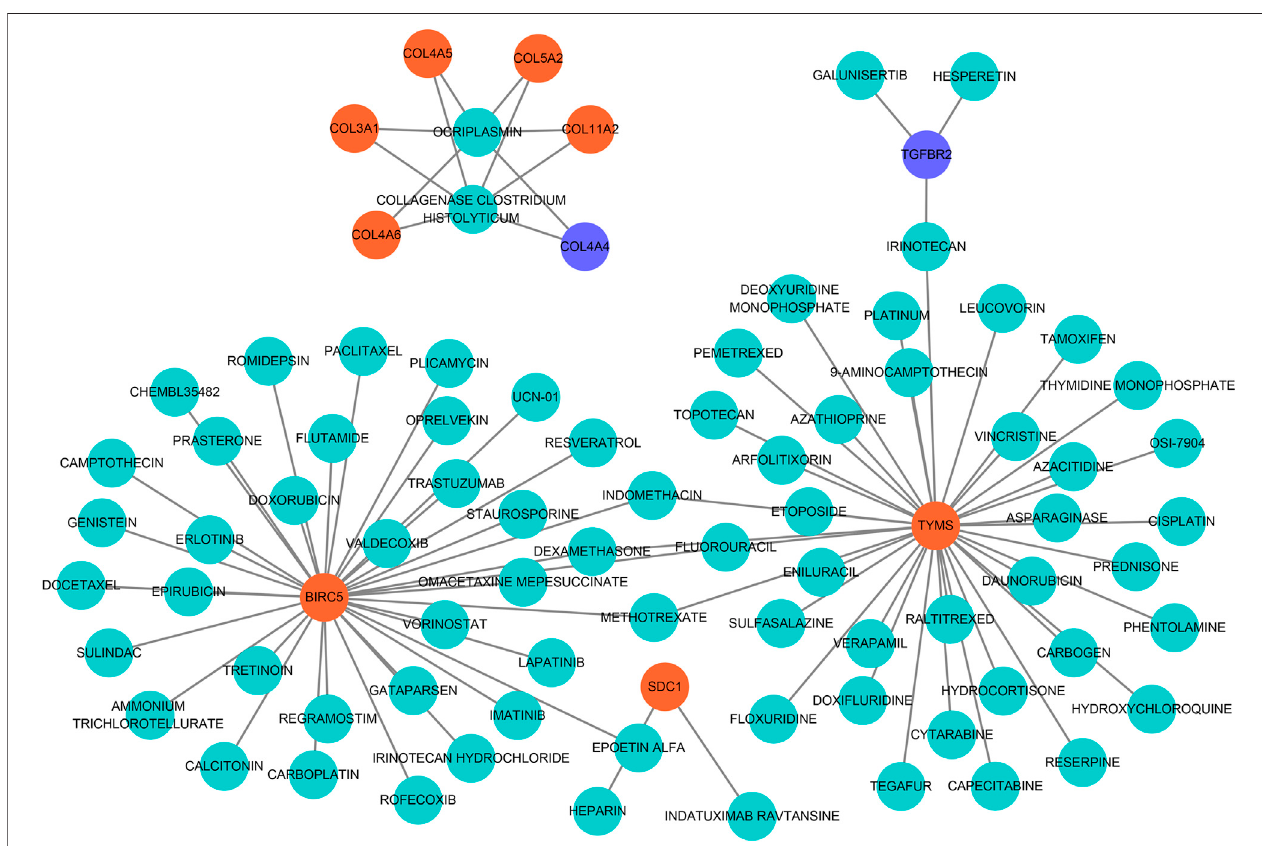
FIGURE 6 | Drug-hub DEGs regulatory networks. Cyan circles, potential target drugs; Orange circles, upregulated DEGs; Purple circles, downregulated DEGs.